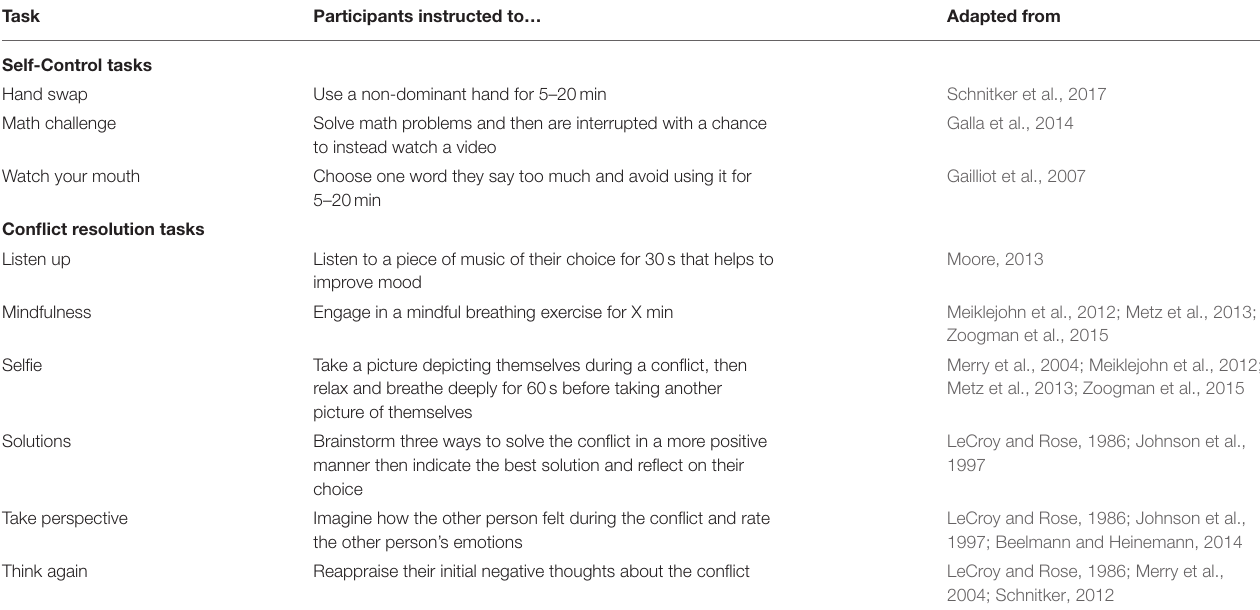
TABLE 1 | Description of CharacterMe tasks.